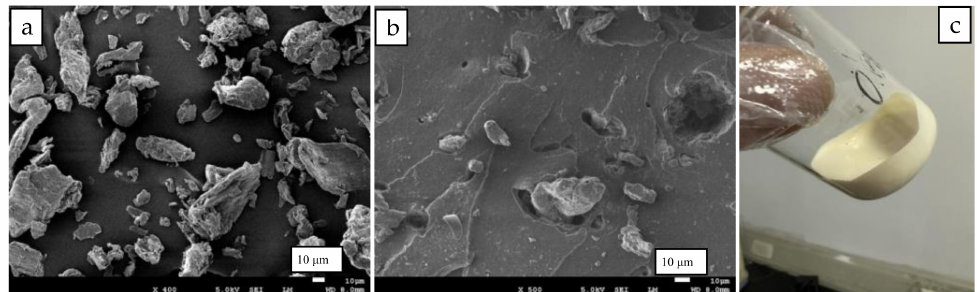
Figure 1. ( a ) SEM image of MCC; ( b ) SEM image of the tensile fracture of MCC/NR composites; ( c ) optical photo of cellulose solution mixed with NR